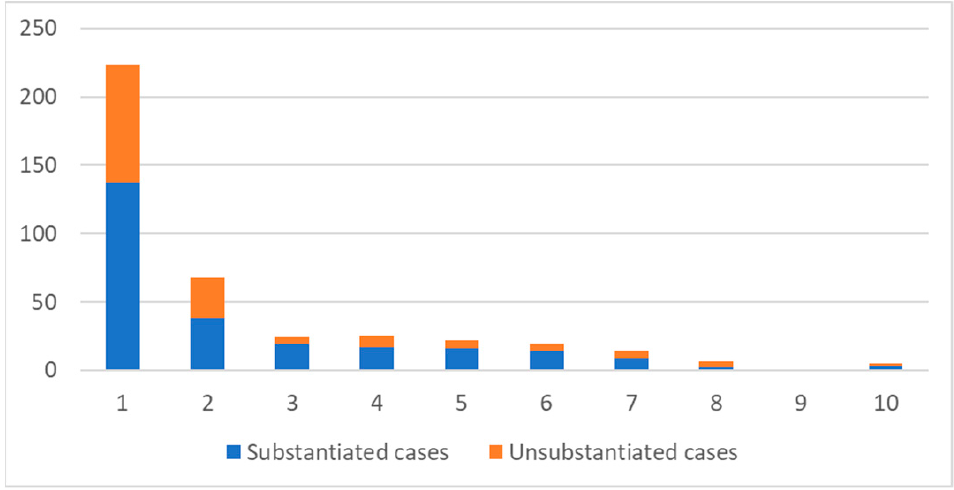
Figure 1. Number of cases in each IMD decile for neighbourhood postcode.